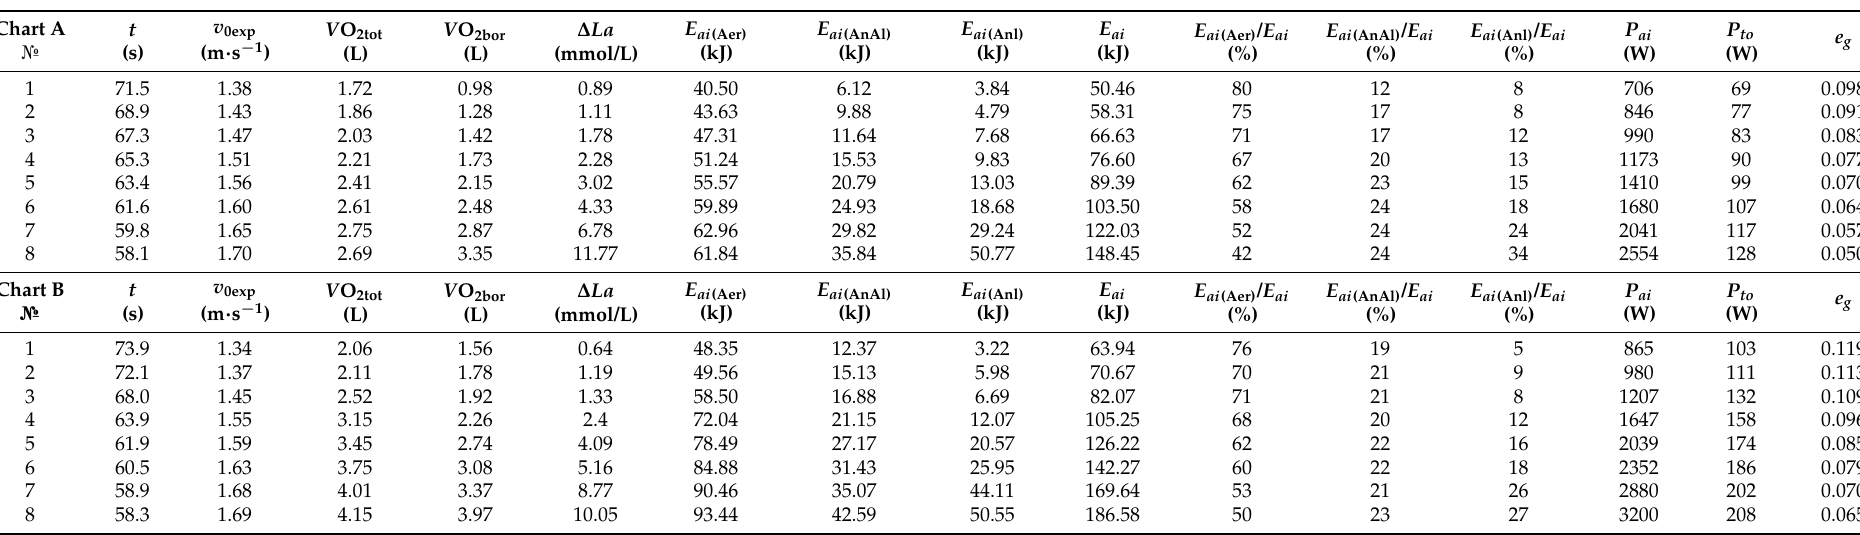
Table 1. Standard protocol of experimental records of the results in the swimming pool 8 × 100 m step-test for female subject F1 (chart A, front crawl, height—1.82 m, weight—62.6